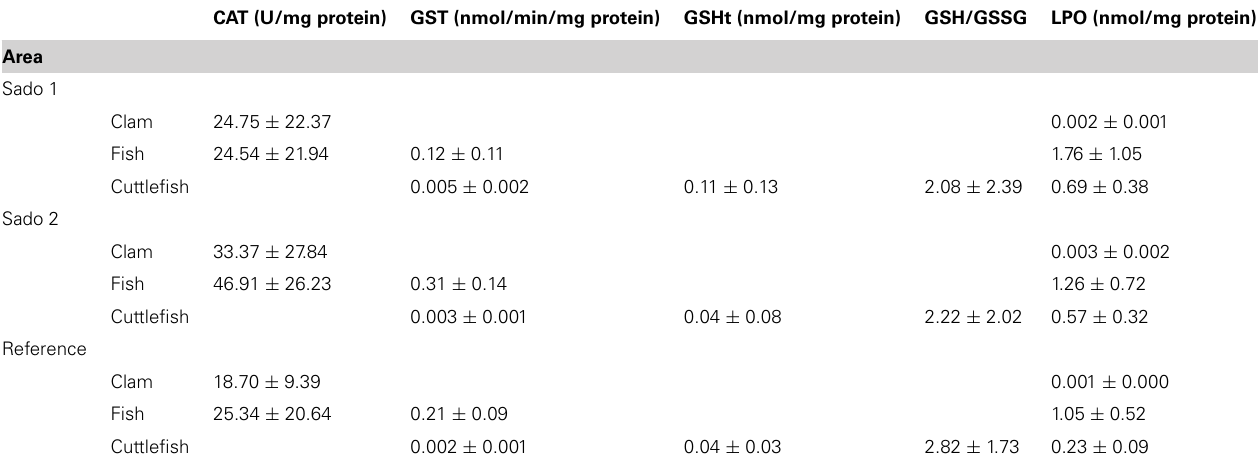
Table 2 | Mean biomarker data ( ± SD) analyzed in the present work, for each species collected from the three study areas: Sado 1 (north); Sado 2 (south), and Reference.